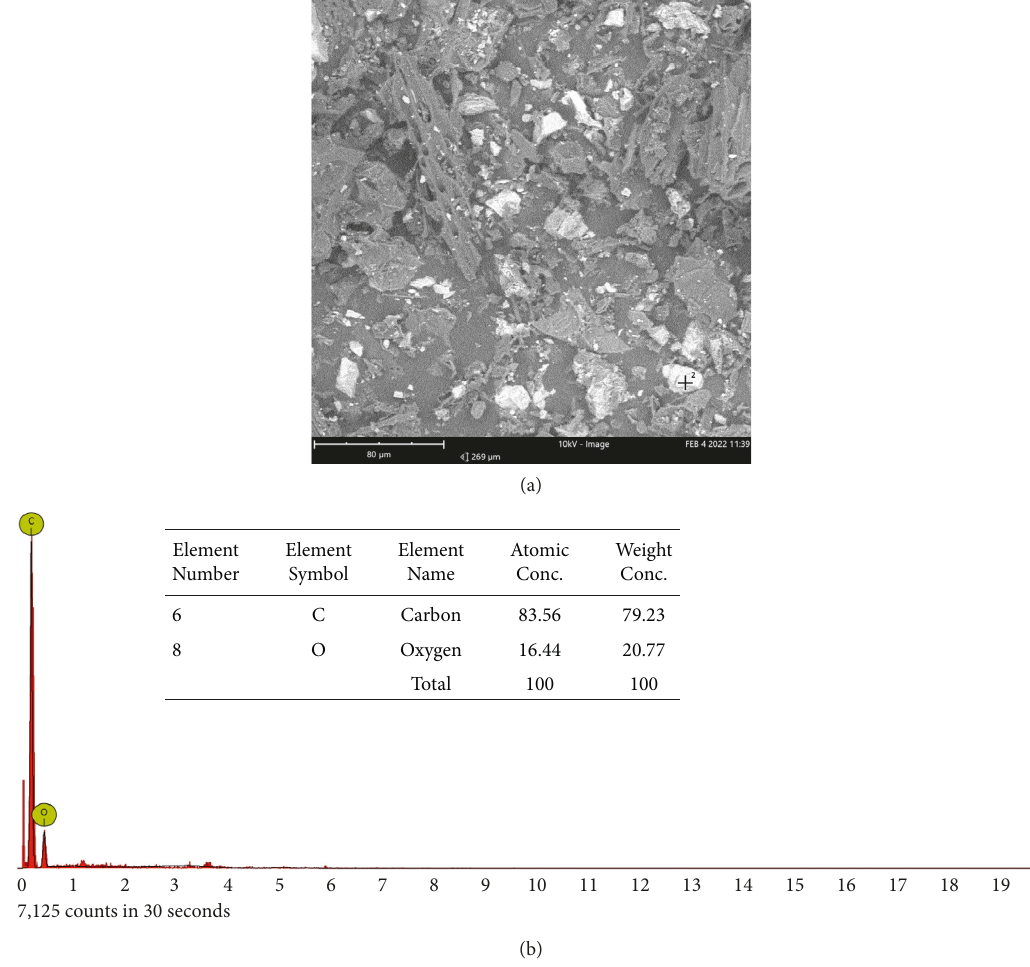
Figure 7: (a) BSED image of the BAC-P adsorbent before adsorption showing the spectrum used for EDX analysis. (b) The corresponding EDX spectrum at the spectrum point as indicated in